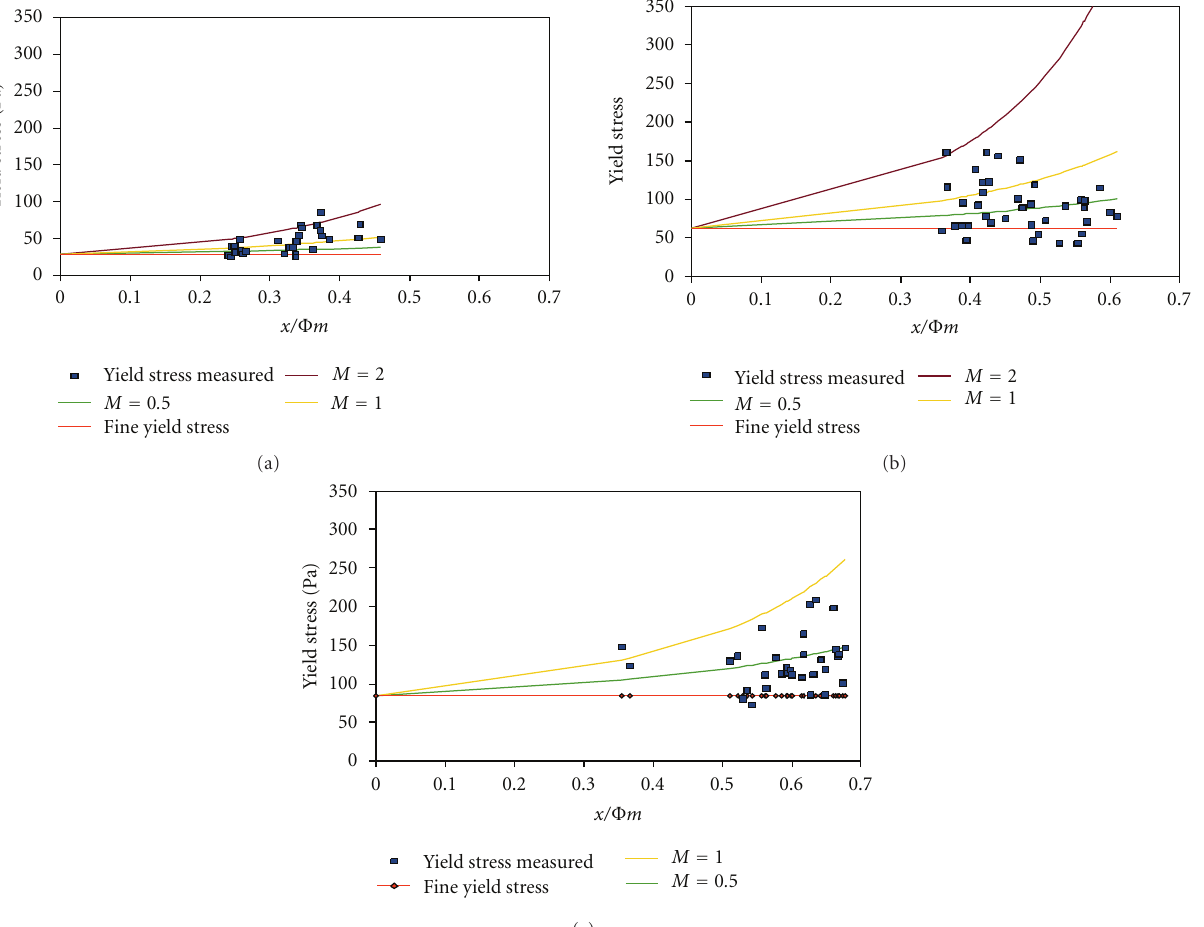
Figure 5: Relation between granular fraction of the interstitial fluid (fine water).